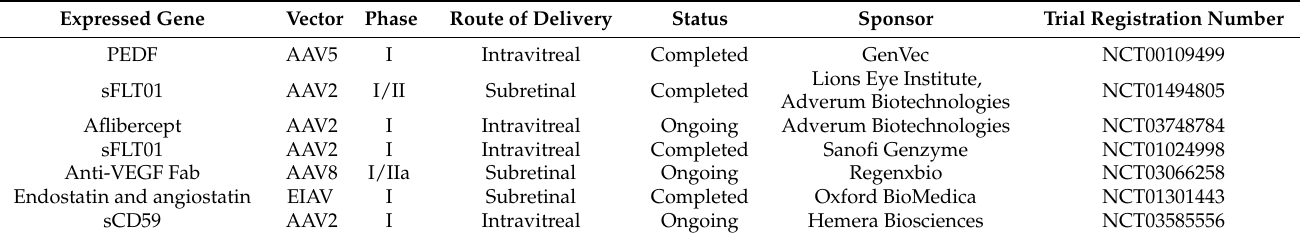
Table 5. Completed and ongoing gene therapy clinical trials for nAMD. Adapted from